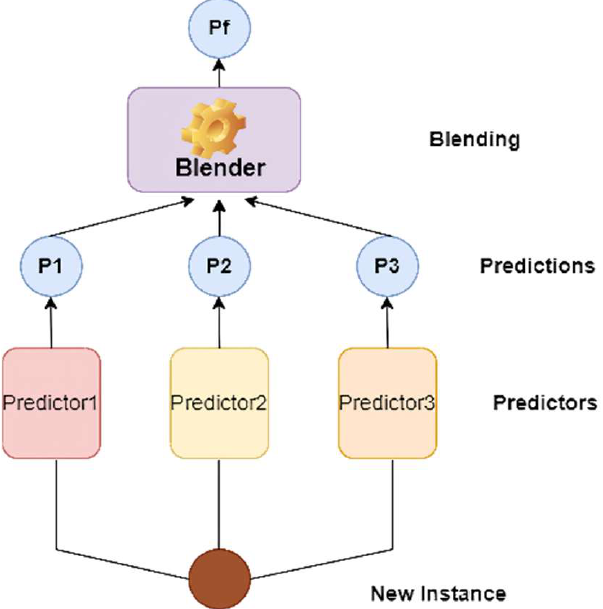
Figure 6. Aggregating predictions using a blending predictor: P1, P2, and P3 are the predictions from all three predictors, respectively, and Pf is the final prediction from the blender.